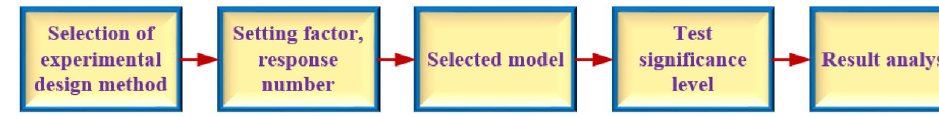
Figure 15. Design-Expert software flow chart.